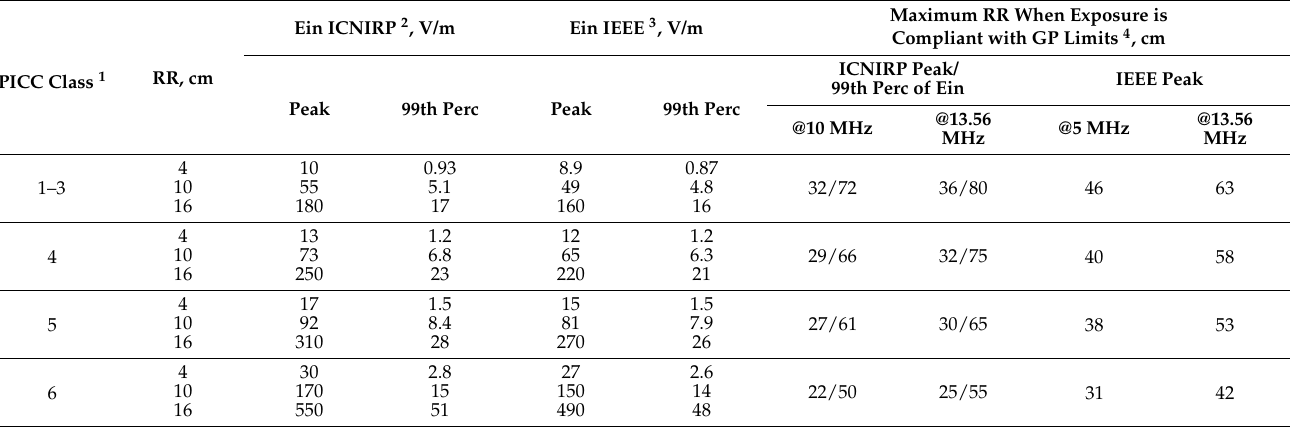
Table 6. Ein values in the model of a person validating a public transport card in an exposure scenario with two people near to the HF RFID reader (at 13.56 MHz) with an internal antenna with inner dimensions of 8 × 8 cm, assuming that the RR of the considered reader is 4, 10 or 16 cm (according to ISO/IEC 14443-2:2020 requirements for PICCs of various classes).